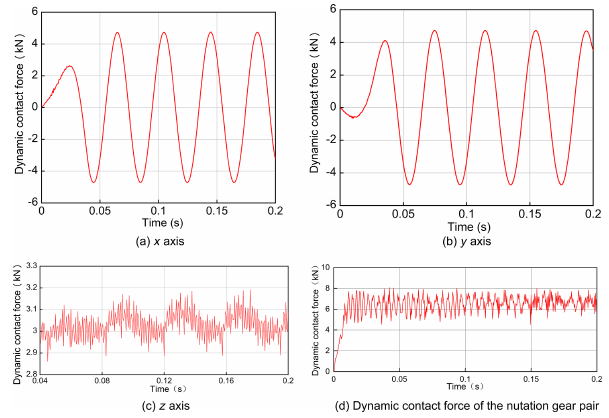
Figure 13. Vibration velocity under different input speeds.